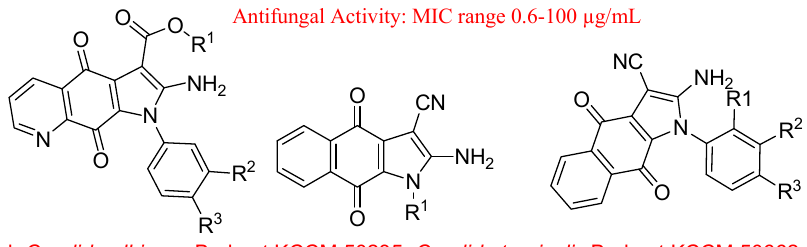
Figure 42. 1 H -Pyrrolo[3,2-g]quinoline-4,9-diones and 4,9-dioxo-4,9-dihydro-1 H